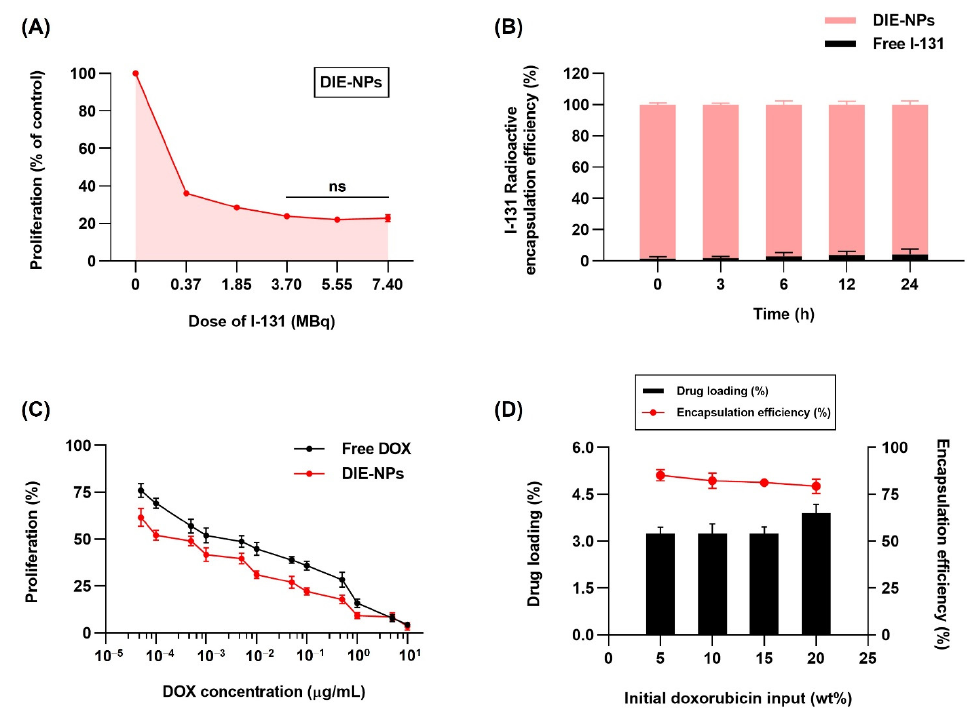
Figure 5. The two-dimensional (2D) in vitro therapeutic optimization. ( A ) MTT assay in vitro cyto- toxicity of DIE-NPs at dosages of 0, 0.37, 1.85, 3.70, 5.55, and 7.40 MBq after 24 h incubation. ns = no statistically significant difference in efficacy of destroying cancer cells between 3.70, 5.55, and 7.40 MBq ( p > 0.05). ( B ) I-131 radioactive encapsulation efficiency (%) of DIE-NPs and free I-131 after 0, 3, 6, 12 and 24 h incubation. ( C ) In vitro cytotoxicity using MTT assay of DIE-NPs and free DOX after 24 h incubation. ( D ) Drug loading and encapsulation efficiency (%) of 5%, 10%, 15%, and 20% initial doxorubicin input (wt%). Data are given as mean ± standard deviation ( n =